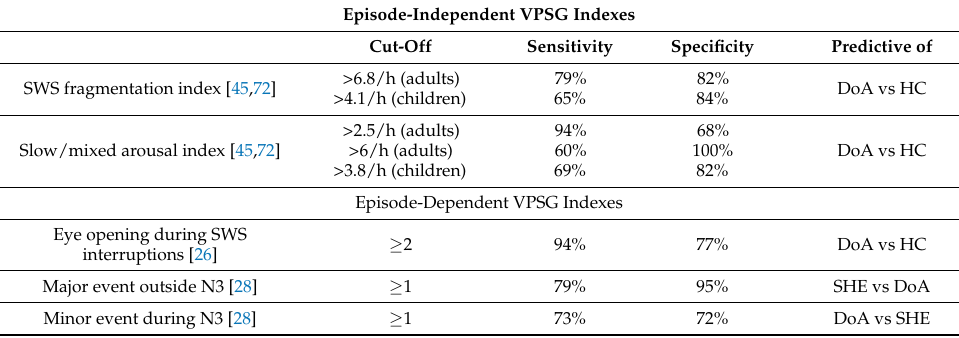
Table 5. Indexes proposed on the base of